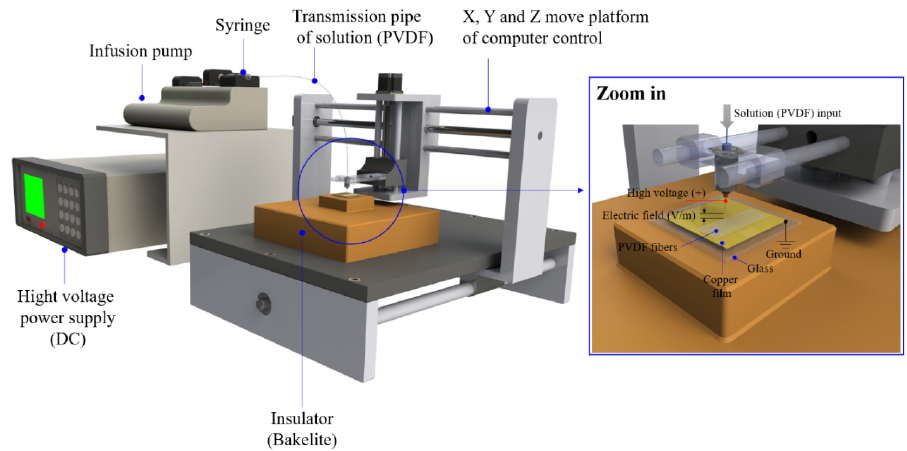
Figure 1. Developed a direct-write near-field electrospinning (DW-NFES) platform.